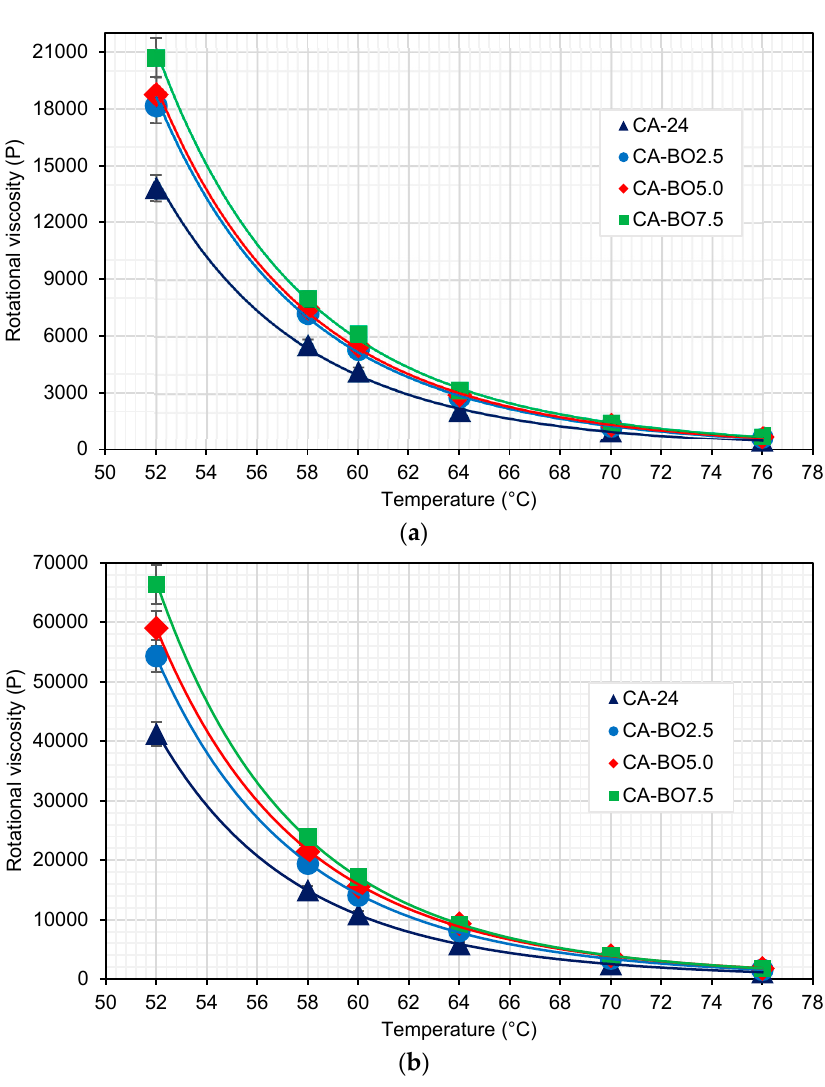
Figure 7. Rotational viscosity between 52 and 76 °C of asphalt binder samples analyzed at: ( a ) original state and ( b ) aged by RTFOT.